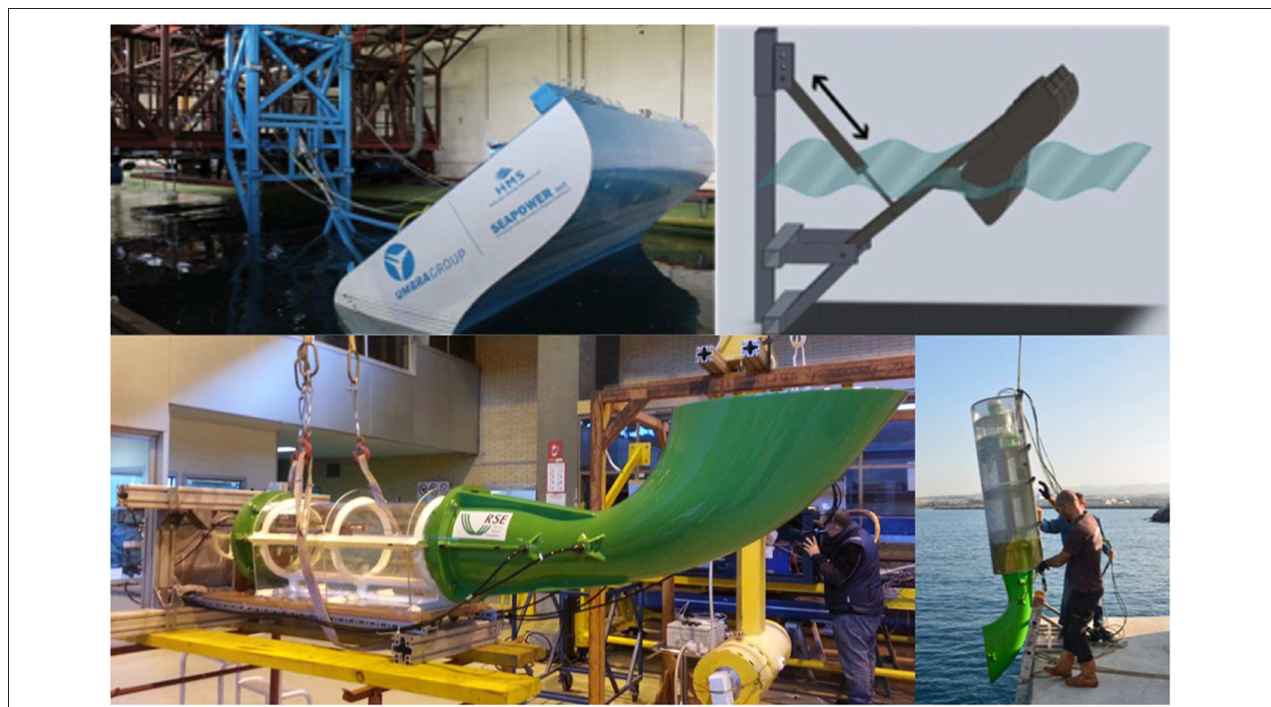
FIGURE 8 | (Top) Full scale GEL prototype (Left) and schematic representation of GEL (Right). (Bottom) Full scale WAVESAX prototype (Left) and its deployment in Civitavecchia (Right).